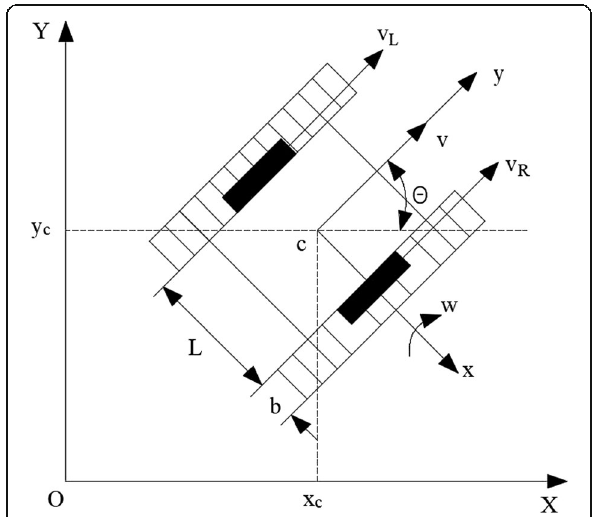
Fig. 1 Position and attitude diagram of tracked mobile